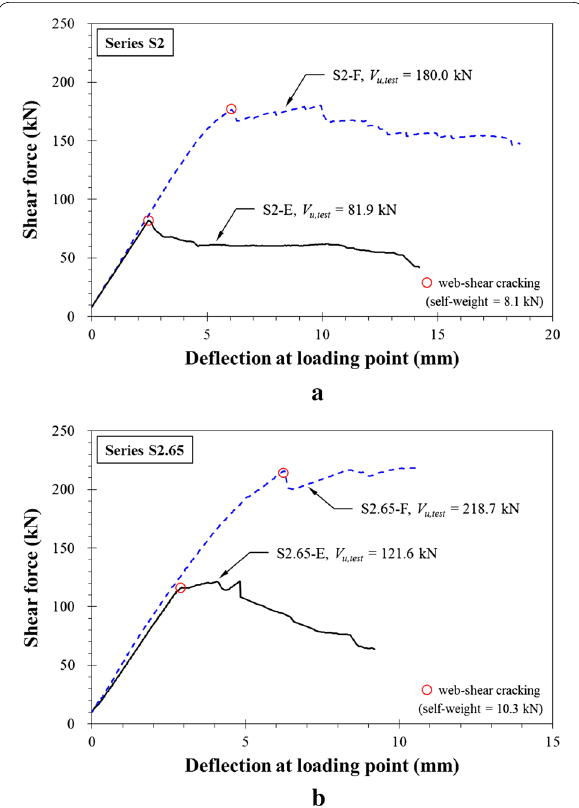
Fig. 9 Load‑displacement reponses of specimens series S4 and S5. a Specimens series S4, b specimens series